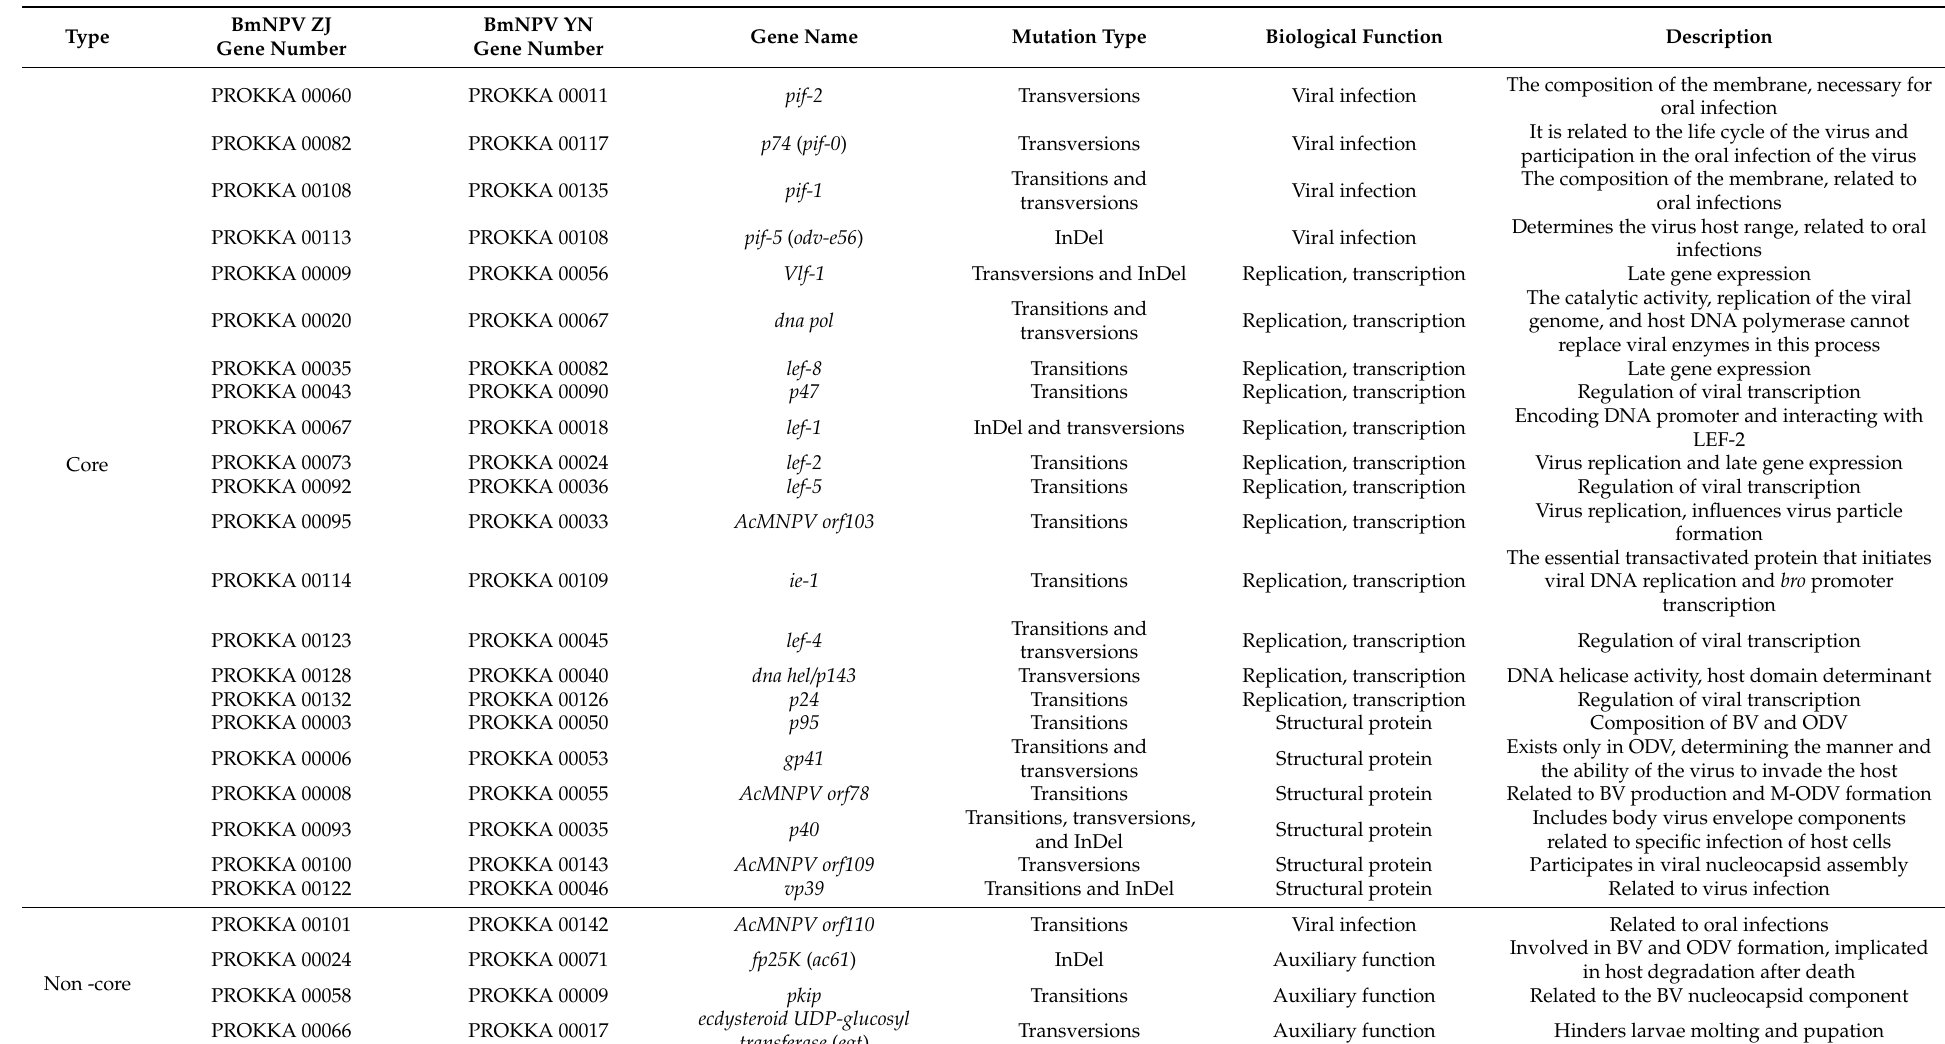
Table 8. Viral functional genes with non-synonymous mutations and frameshift